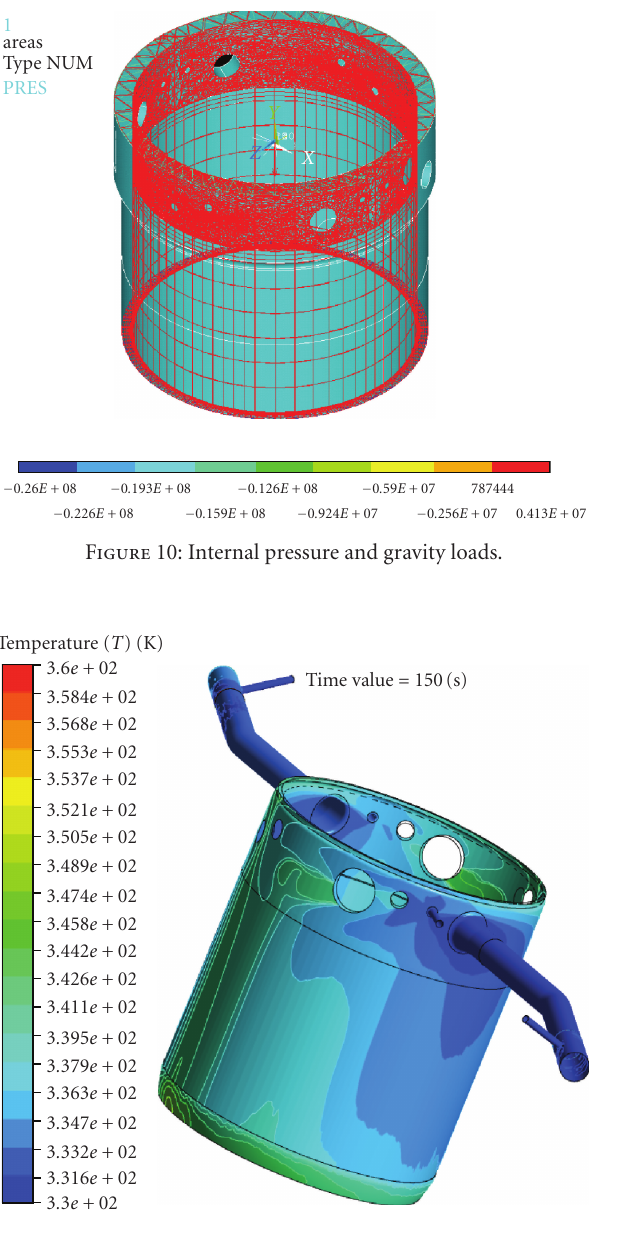
Figure 11: CFX temperature profile results on downcomer surface after 150 s.